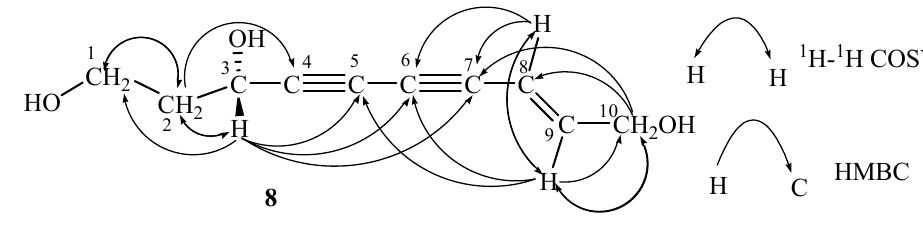
Figure 2 . The key HMBC and 1 H- 1 H COSY correlations of compound 8